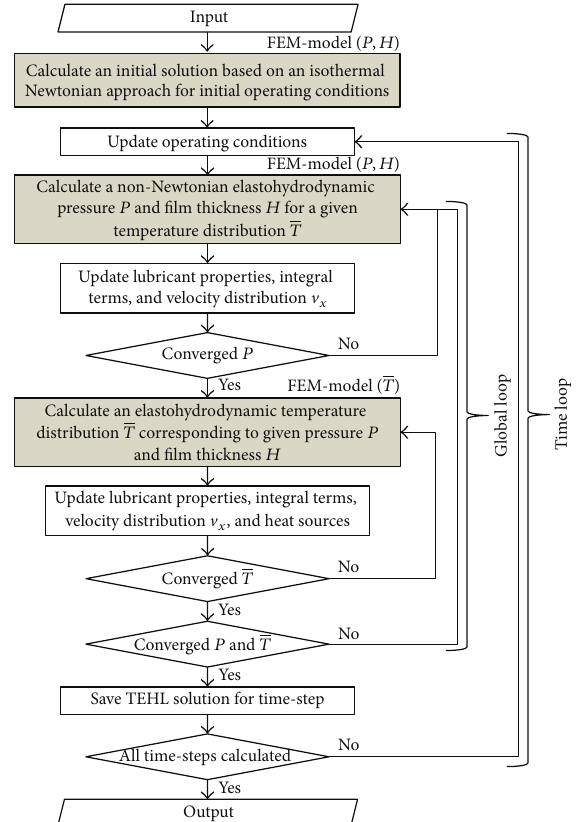
Figure 2: Numerical solution